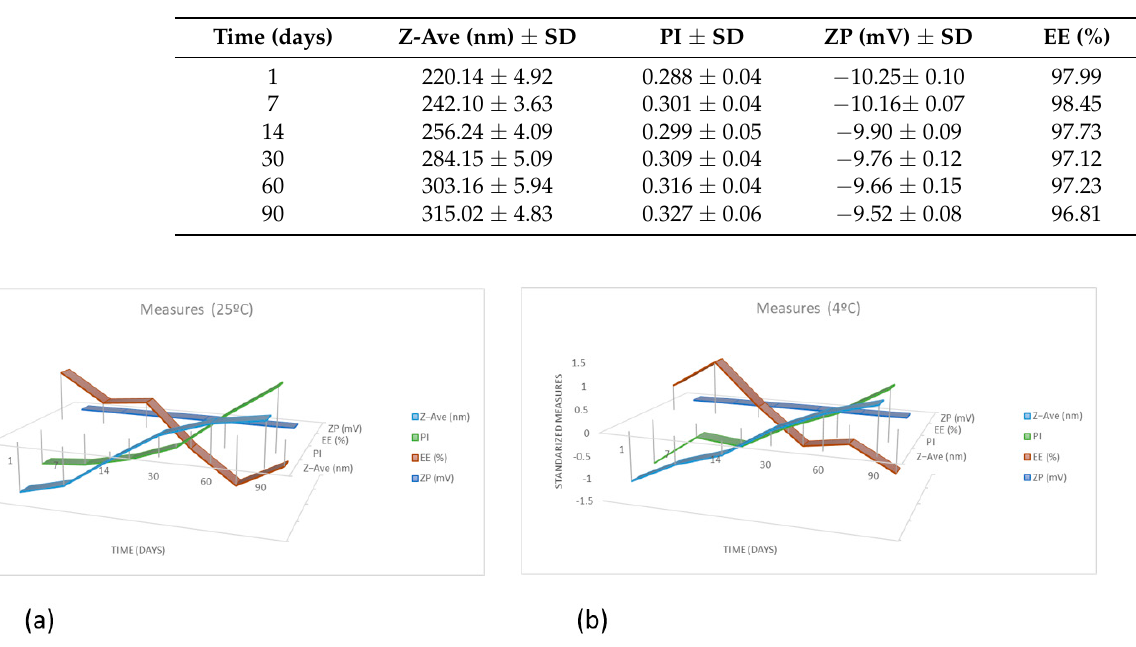
Table 10. The results of the permeation parameters of PF at 6 h from the selected formula in the different mucosal tissues tested, n = 6 each. The results are reported as the median (maximum and minimum): Flux (Jss), lag time (Tl), partition coefficient P1, diffusion coefficient P2, permeability coefficient (Kp).